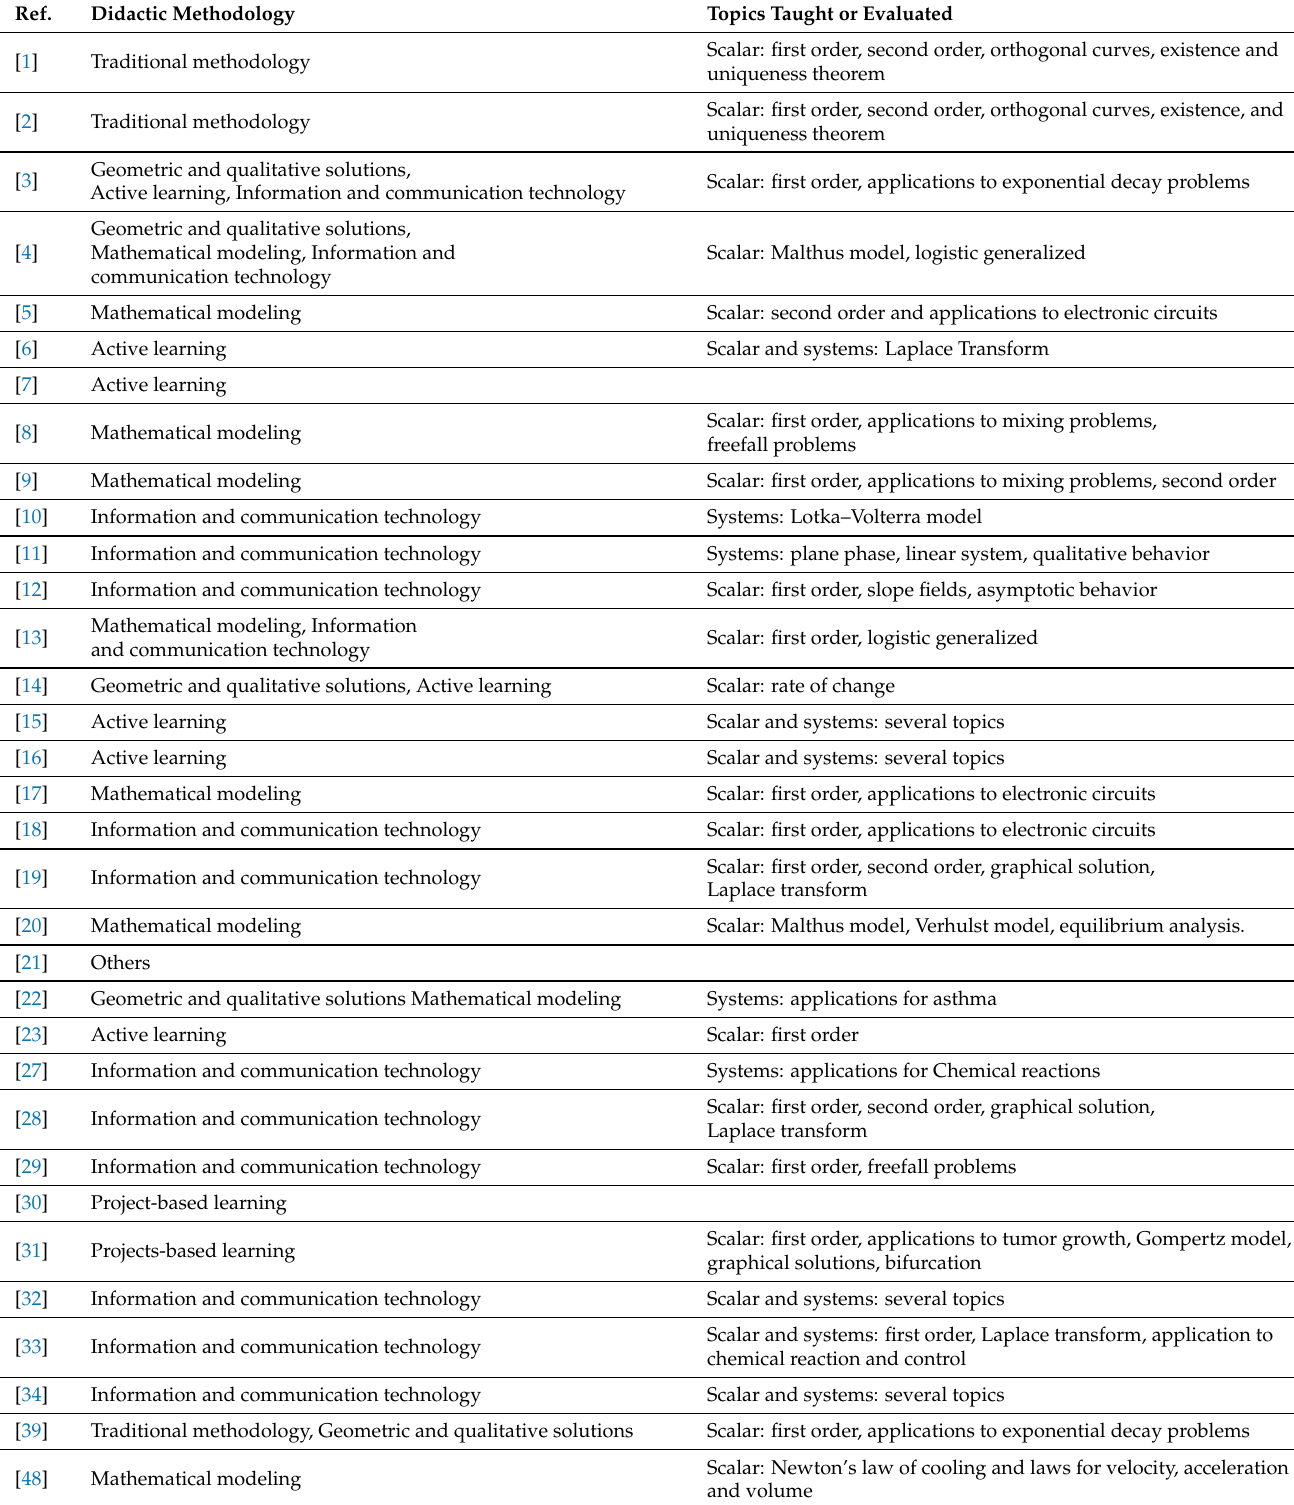
Table 6. Summary of didactic methodologies and the topics of ordinary differential equations declared on the list of retained list of papers (see last paragraph of Section 4). Here Ref. is used for abbreviation of the reference number in the list of